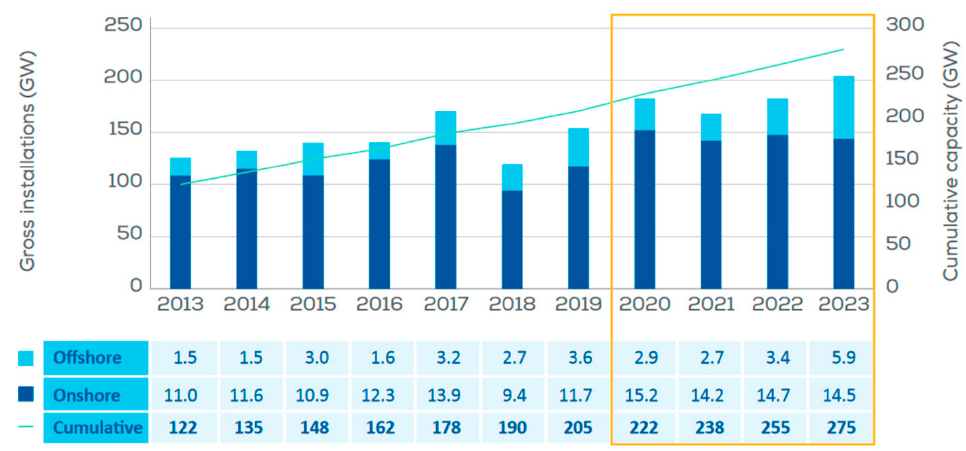
Figure 14. Gross annual wind turbine installations in Europe [13].